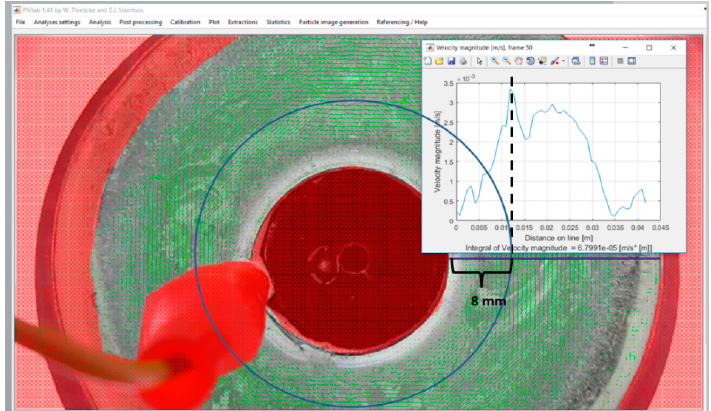
Figure 12. 2D PIVLAB toolbox analysis results for experiment C.